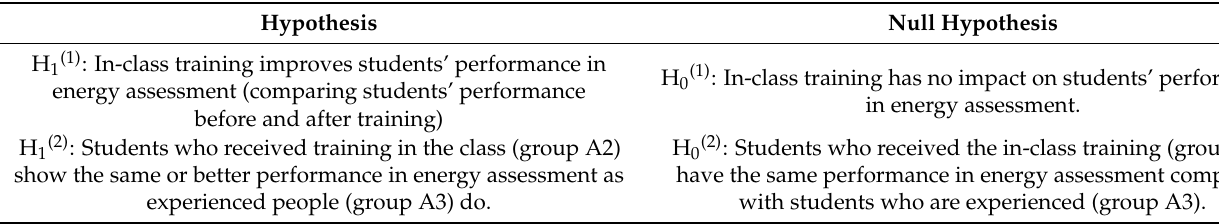
Table 2. Proposed Table 2. Proposed hypotheses.